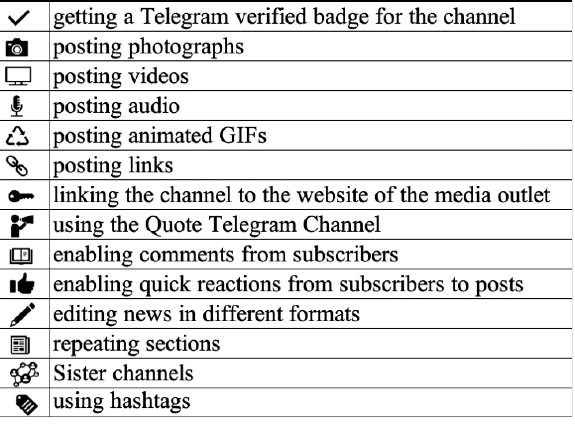
Figure 2. Features analyzed. Source: own elaboration.